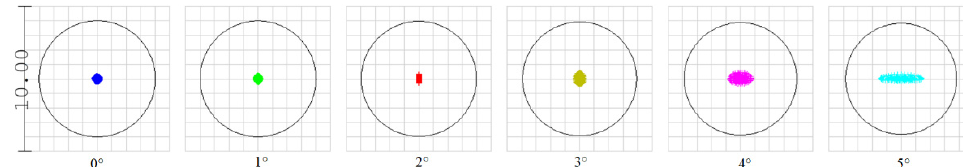
Figure 9. The distribution s of the point diagram with different angles, the circles are the Airy disks.